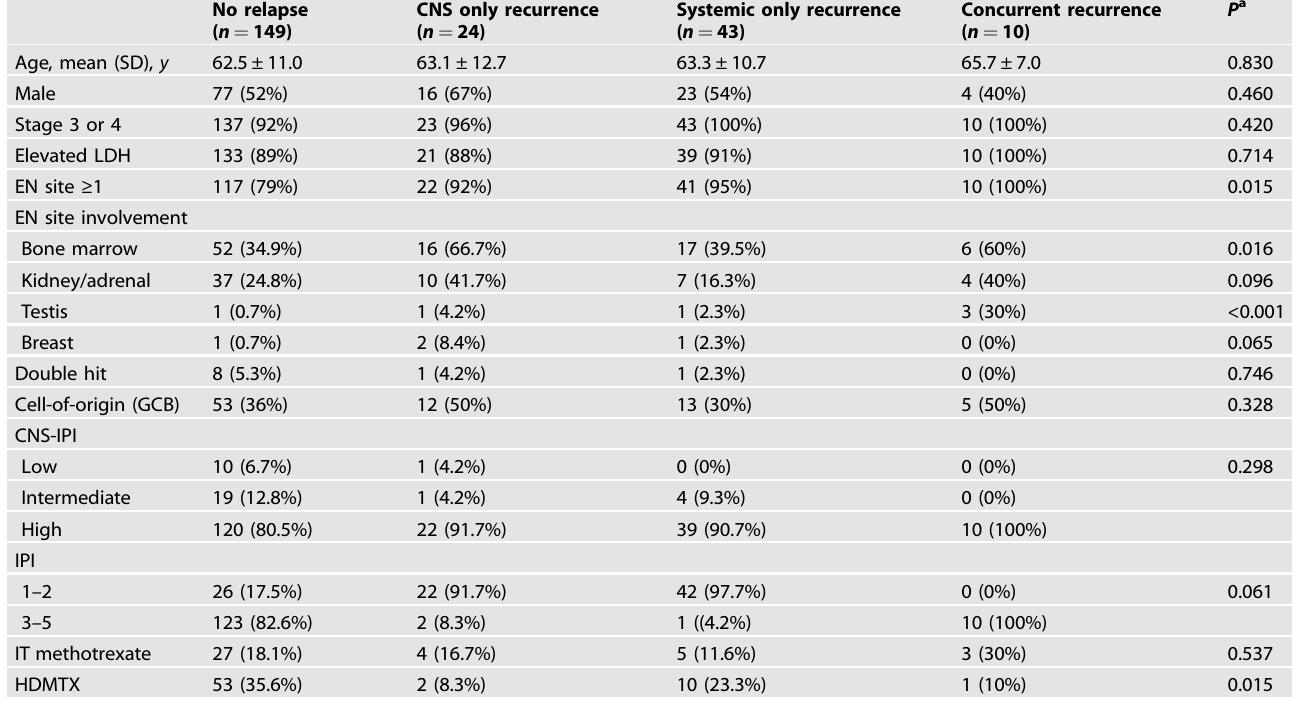
Table 1. Baseline patient